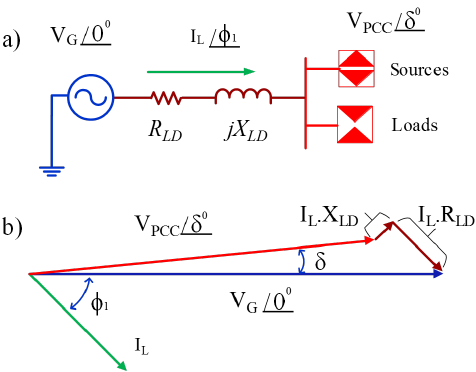
Figure 5. Grid/MG connection model. ( a ) Equivalent circuit. ( b ) Phasor